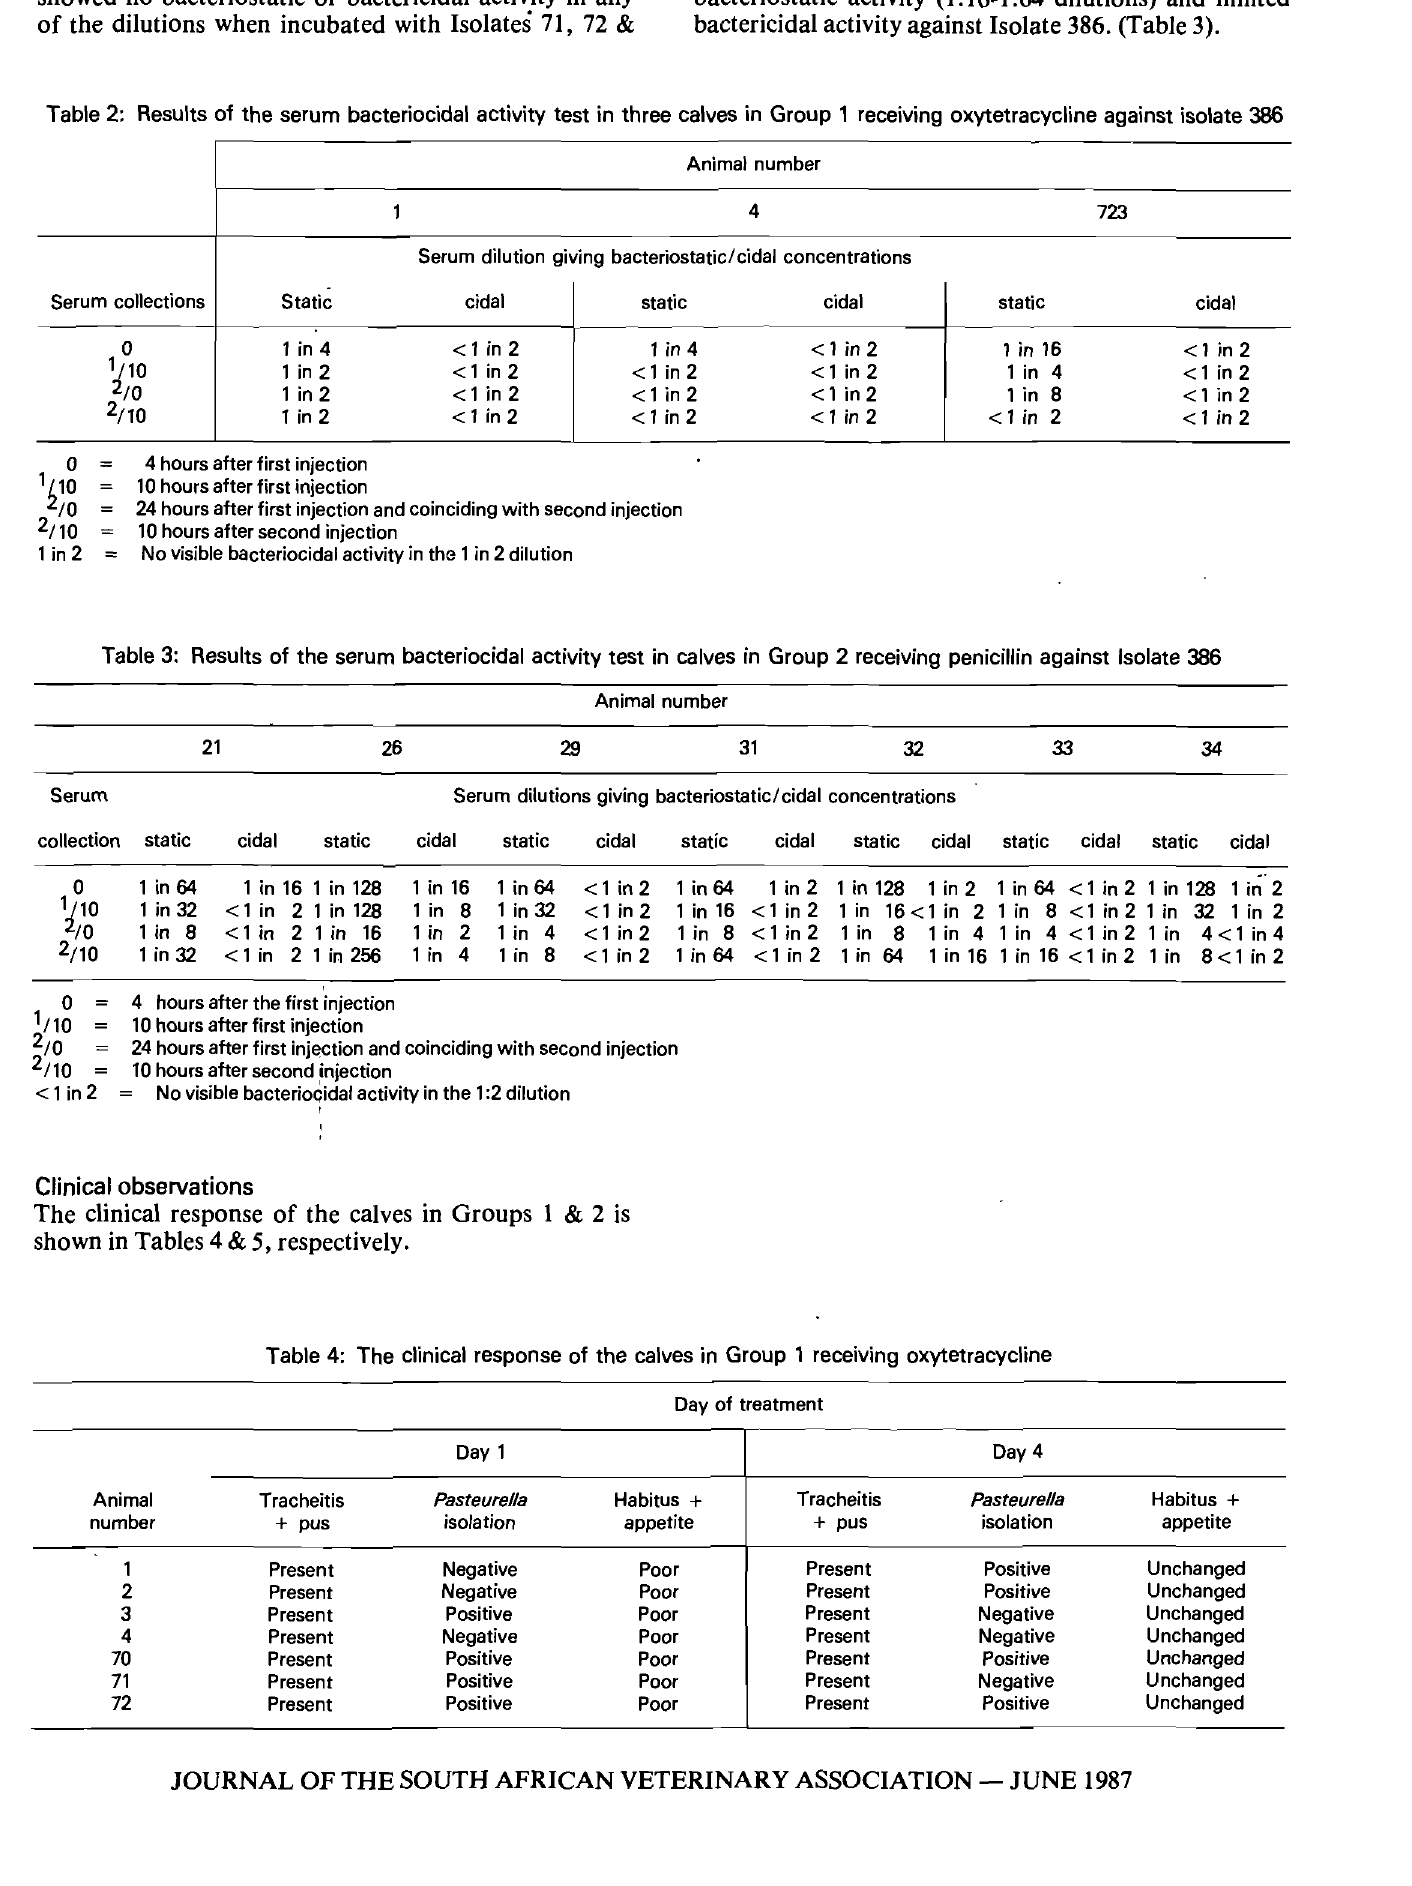
Table 4: The clinical response of the calves in Group 1 receiving oxytetracycline Day of